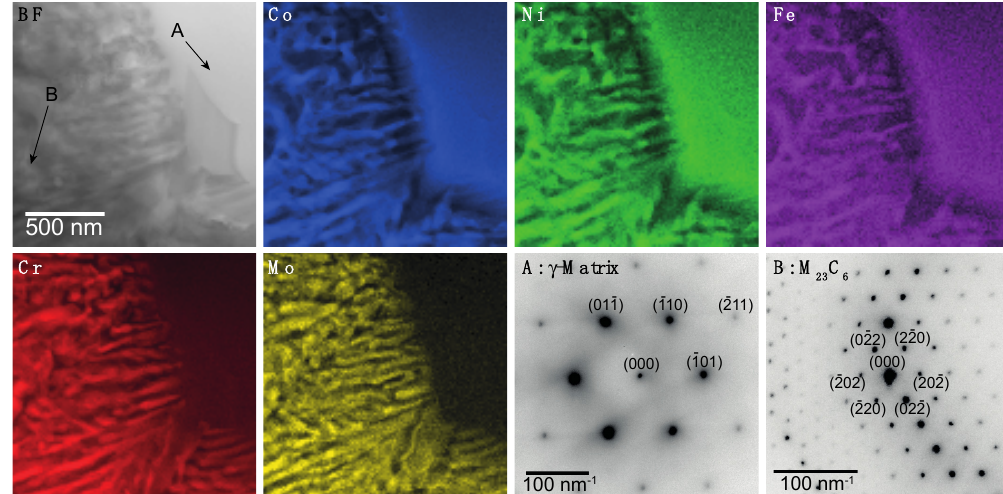
Figure 9. Bright field (BF) image of a region of interest in Stellite-21 with corresponding STEM-EDX elemental distribution maps of Co, Ni, Fe, Cr and Mo. SADPs of the regions labelled A and B in the BF image, were identified as containing the γ matrix and M 23 C 6 with [111] zone axes. DSC data acquired from Stellite-21 in the as-cast condition, shown in Figure 10, revealed endothermic events with peaks at 1252 °C and 1389 °C. These events were believed to correspond to the melting of the interdendritic and dendritic constituents respectively. As such, a heat treatment of 10 h at 1250 °C was selected for carbide modification whilst minimising the likelihood of incipient melting. The microstructure of the alloy after heat treatment showed near complete dissolution of the interdendritic constituents, Figure 11a, with only a small number of precipitates remaining, Figure 11b. This is in stark contrast to Co-101 where the majority of the carbide network remained intact after the heat treatment. In addition to the dissolution of the carbides, a significant amount of porosity could also be observed in the heat treated Stellite-21 microstructure.